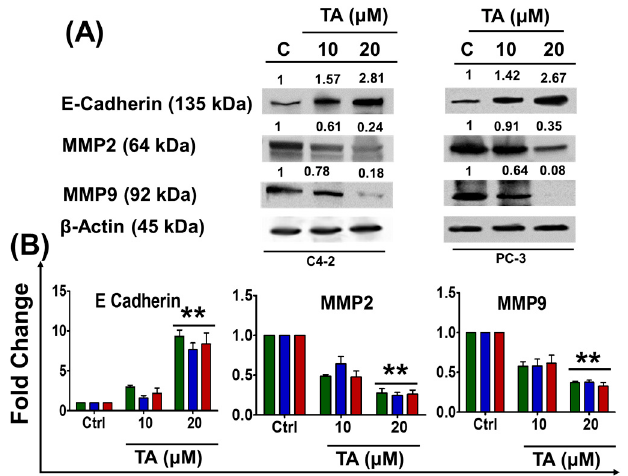
Figure 5. Tannic acid altered the EMT regulatory protein markers in prostate cancer cells. ( A ) Western analysis of Epithelial to Mesenchymal Transition (EMT) markers in TA treated cells. Values shown above the blots are the densitometry analysis of each protein band normalized with respective β -actin value; ( B ) Gene expression studies of EMT markers, such as E-Cadherin, MMP2 and MMP9 in TA-treated cells. Data represent the mean of triplicates ± SEM, ** p < 0.01.